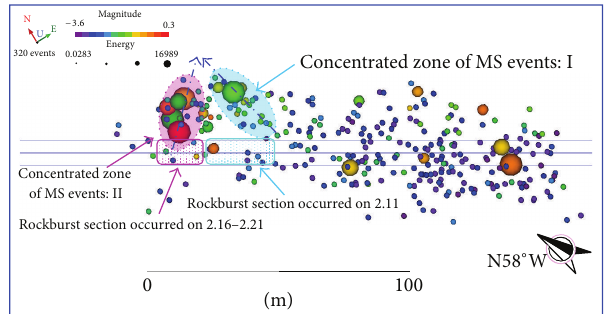
Figure 10: Evolution of rockburst nucleation process during TBM tunneling in diversion tunnel #3 (January 20–March 1,